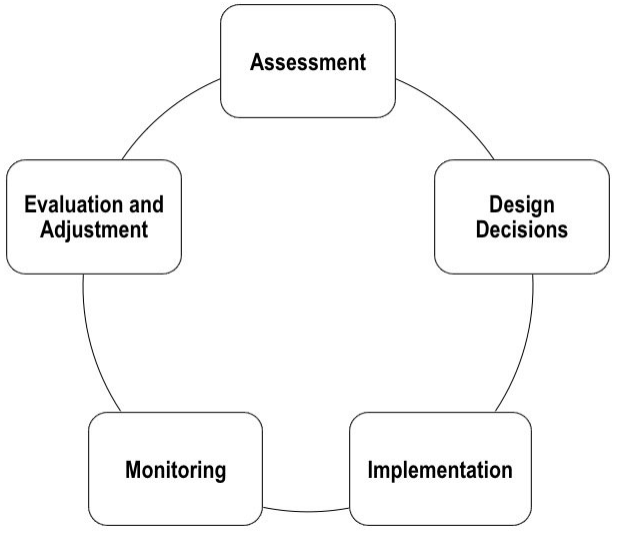
Fig. 1 . The adaptive management cycle (adapted from Chaffin and Gosnell 2015)